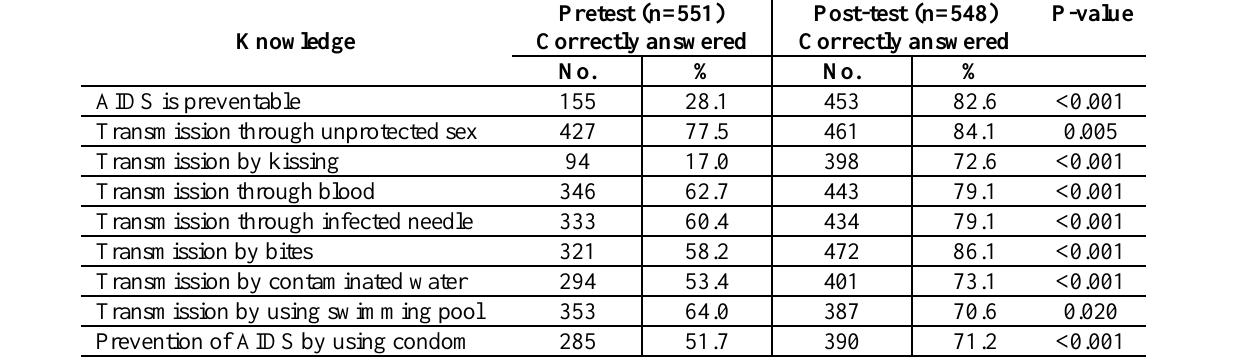
Shrestha et al. Effective of Reproductive Health and AIDS Education Table III : Knowledge about AIDS among adolescent girls